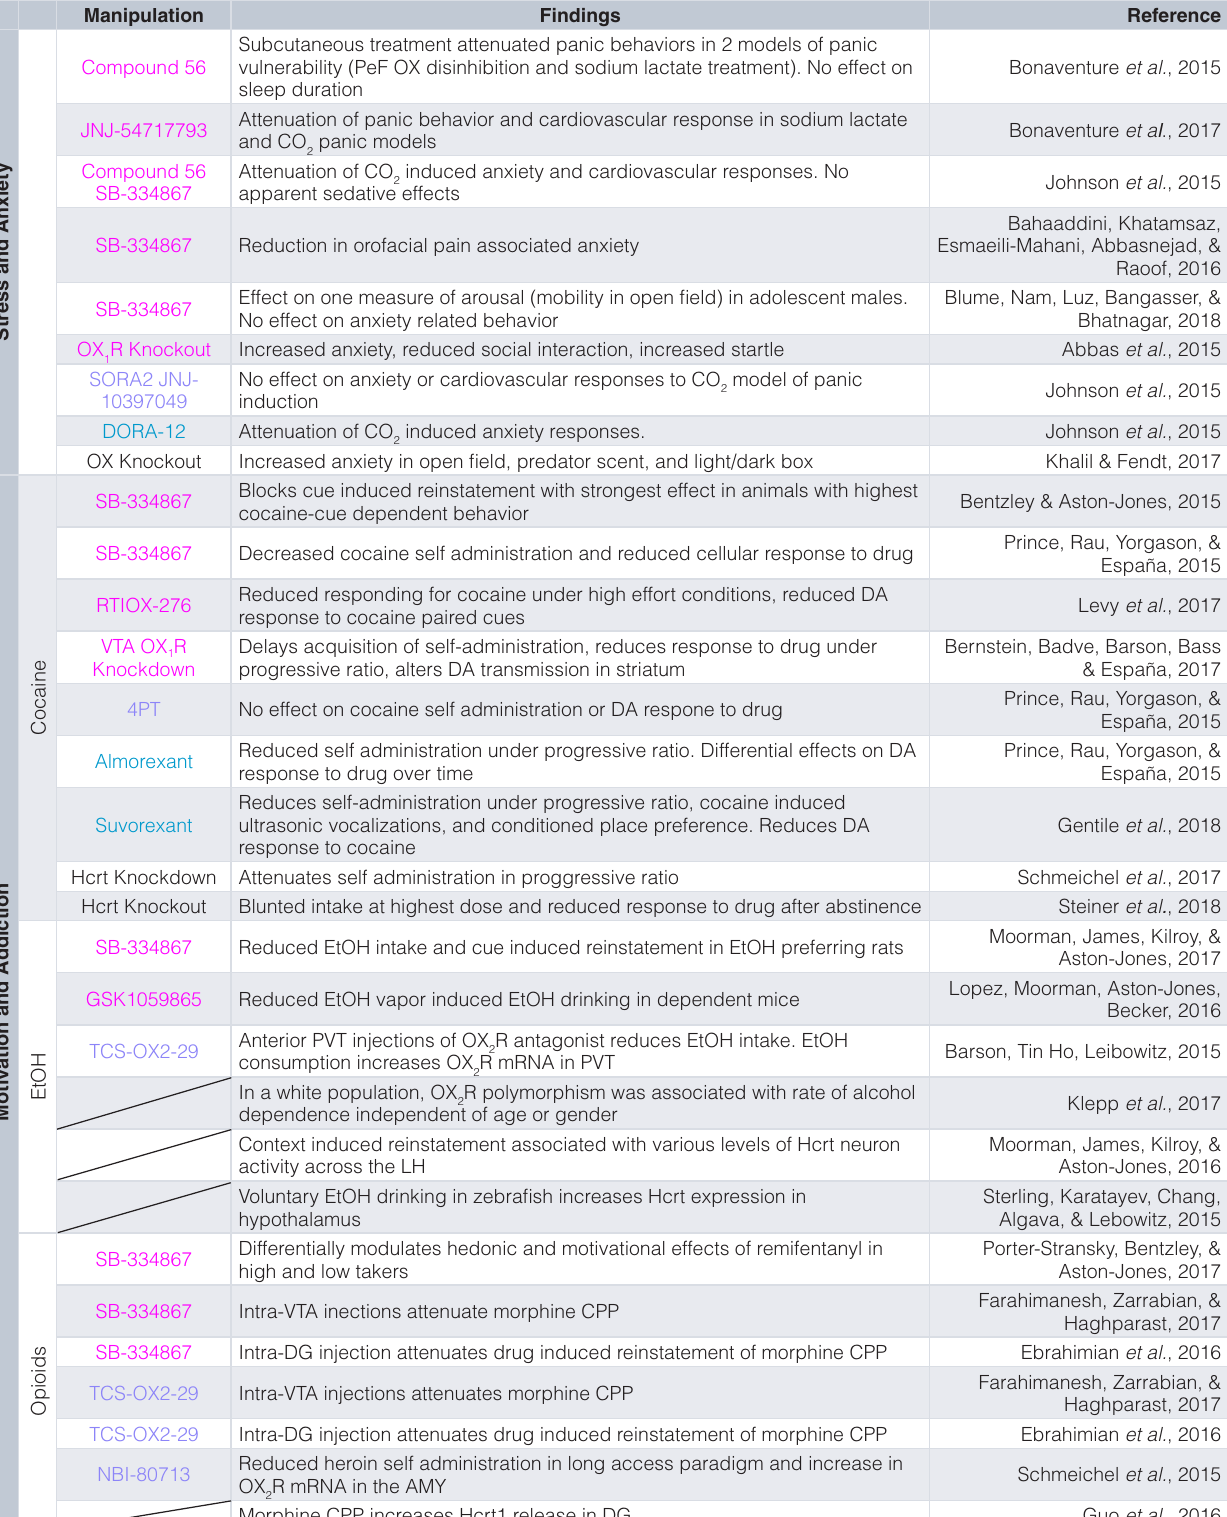
Table 1. Summary of recent findings for hypocretin in relation to affect and motivation. Colors match receptor representation in Figure 2: pink, OX R manipulation; purple, OX R manipulation; blue, OX R/OX R manipulation. AMY, amygdala; CO 1 2 1 2 conditioned place preference; DA, dopamine; DG, dentate gyrus; EtOH, ethanol; Hcrt, hypocretin; LH, lateral hypothalamus; PeF OX, perifornical area orexin; PVT, paraventricular nucleus of the thalamus; VTA, ventral tegmental